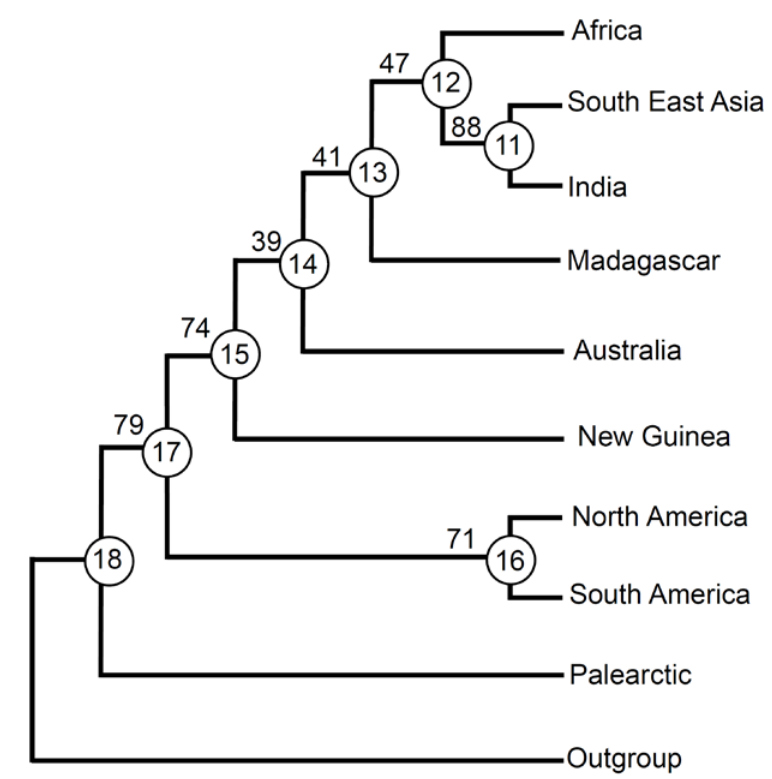
Figure 2. Area relationships found by Cladistic Analysis of Distributions and Endemism (CADE). Circled numbers indicate nodes. Numbers on branches are bootstrap values (percentages).